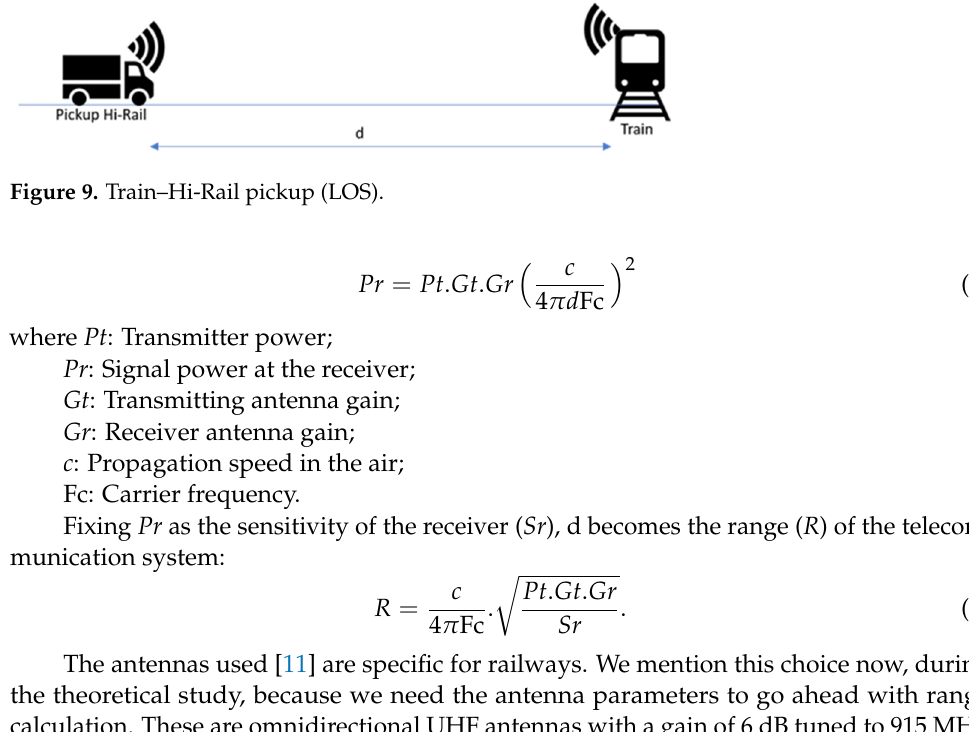
Figure 10. Ground reflection Train-Hi-Rail pickup.